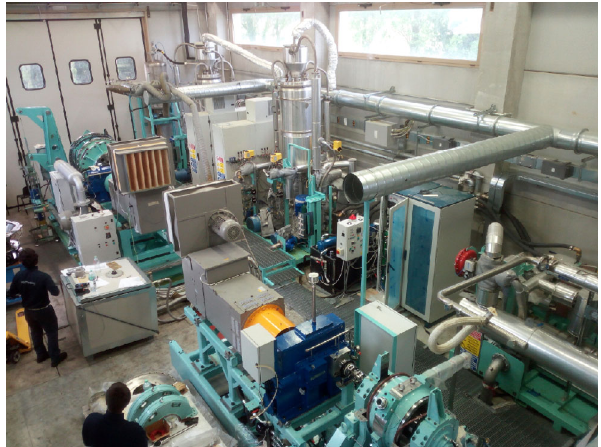
Fig. 1 Image of new laboratory with test rigs and lubrication